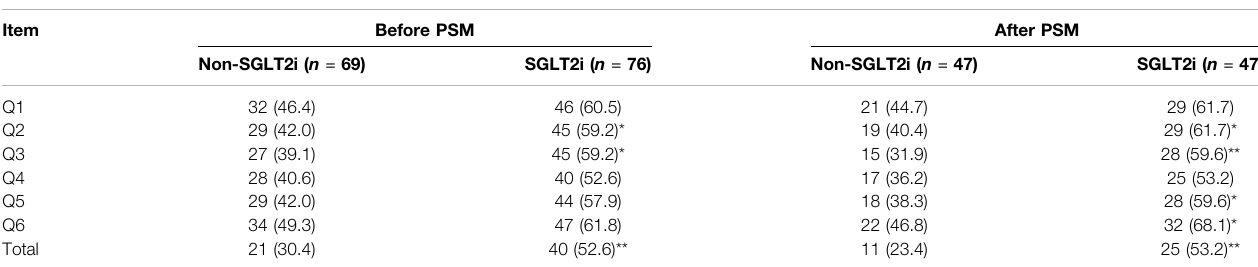
TABLE 4 | Satisfaction rate of each item before and after PSM.